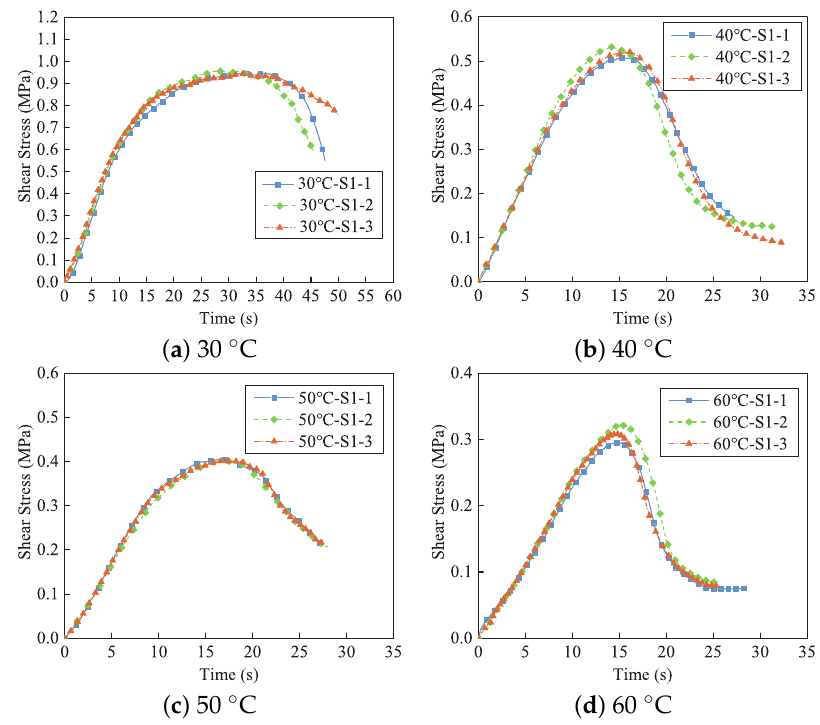
Figure 8. Time dependency of shear stress at four